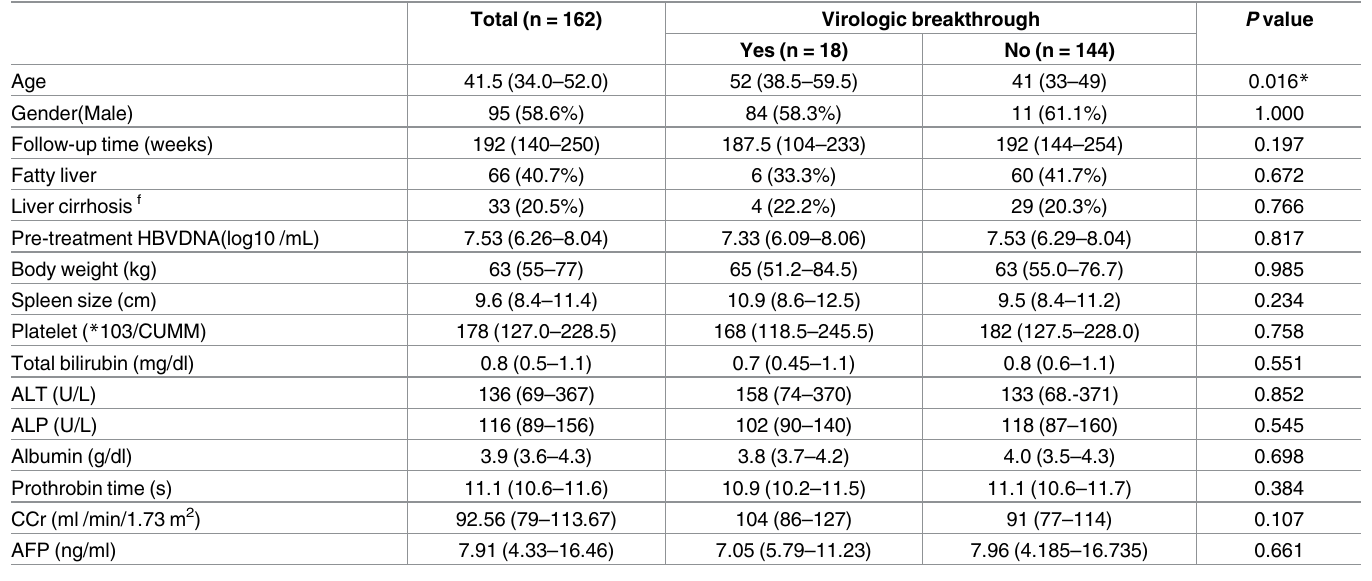
Table 1. Baseline clinical characteristics of patients.